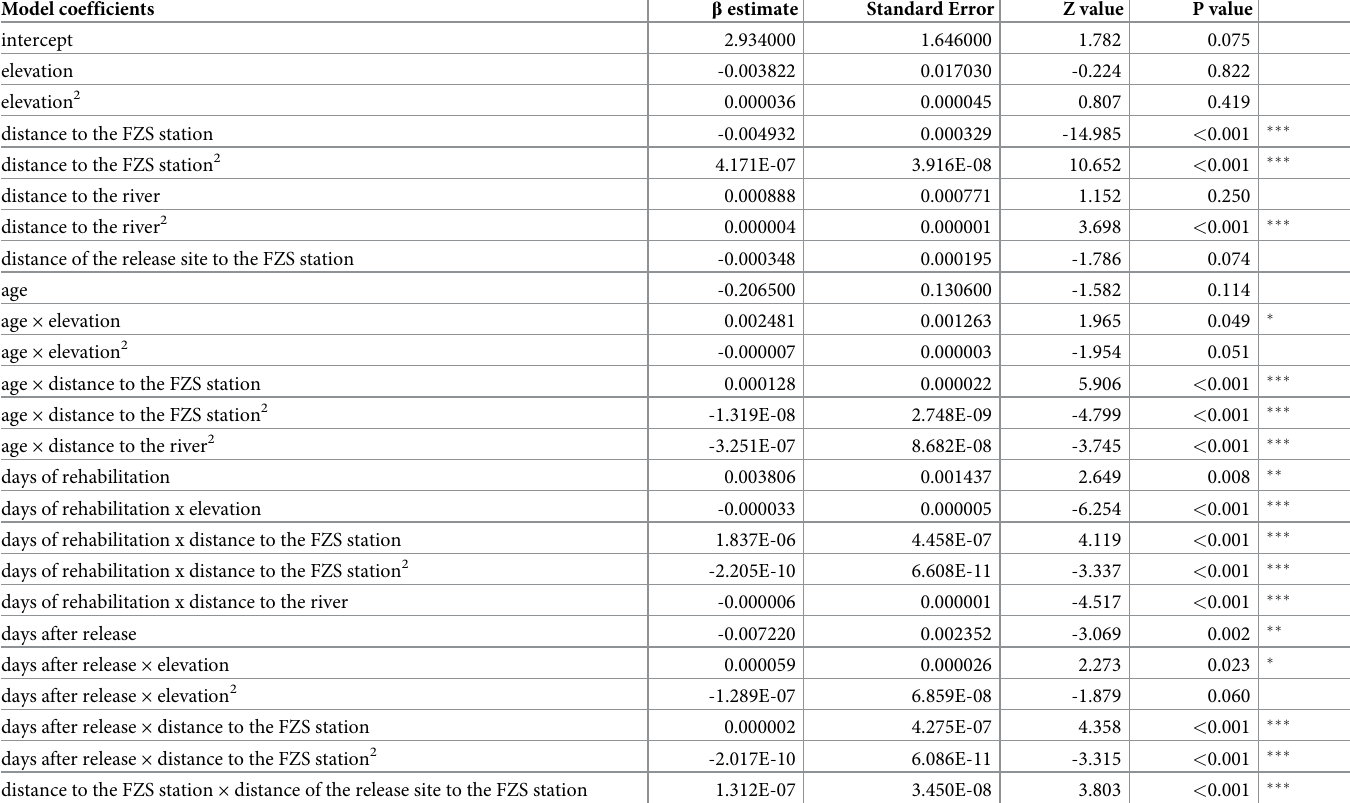
Table 2. Parameters estimated by the Generalized Linear Model (GLM) fitted to depict population-level resource selection by orangutans from 2011 to 2013 in Cen- tral Sumatra. Model